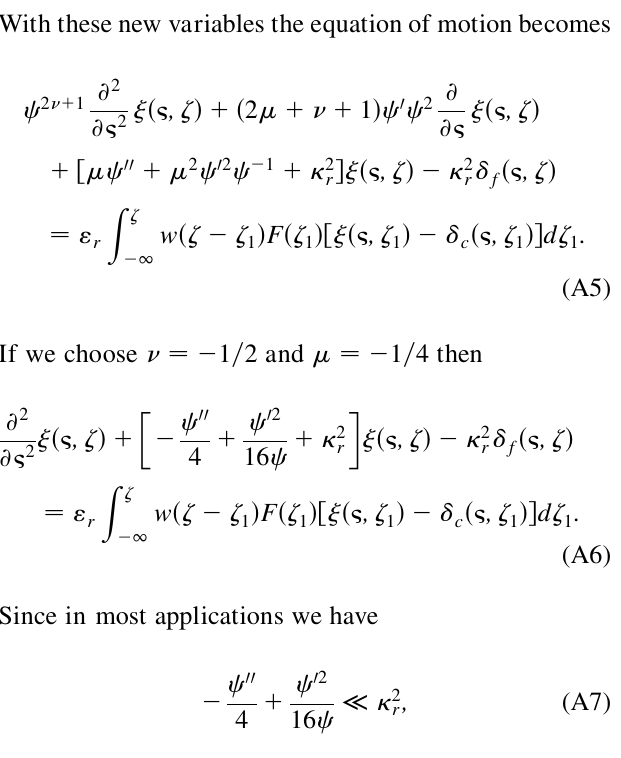
FIG. 8. (Color) Normalized displacement of a train of finite- length bunches with / (cid:7) 0 : 1 , Q (cid:7) 2 (cid:15) 10 3 , (cid:8) (cid:7) 100 : 5 ’ , " (cid:7) 100 , !. (cid:7) 3 : 01 ’ , and (cid:4) (cid:7) 1 . The upper, middle, and lower figures are for the front, middle, and tail of the bunches,